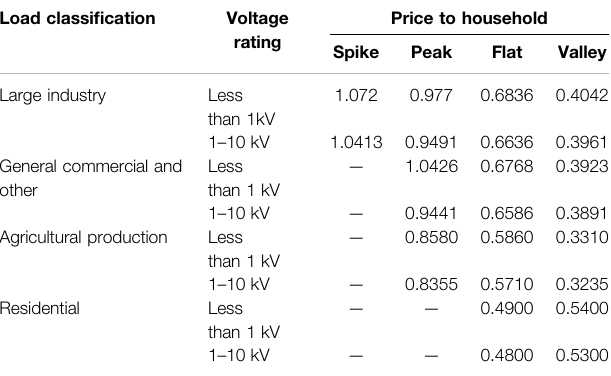
TABLE 3 | Peak and valley tariffs for different load types in the Tianjin power